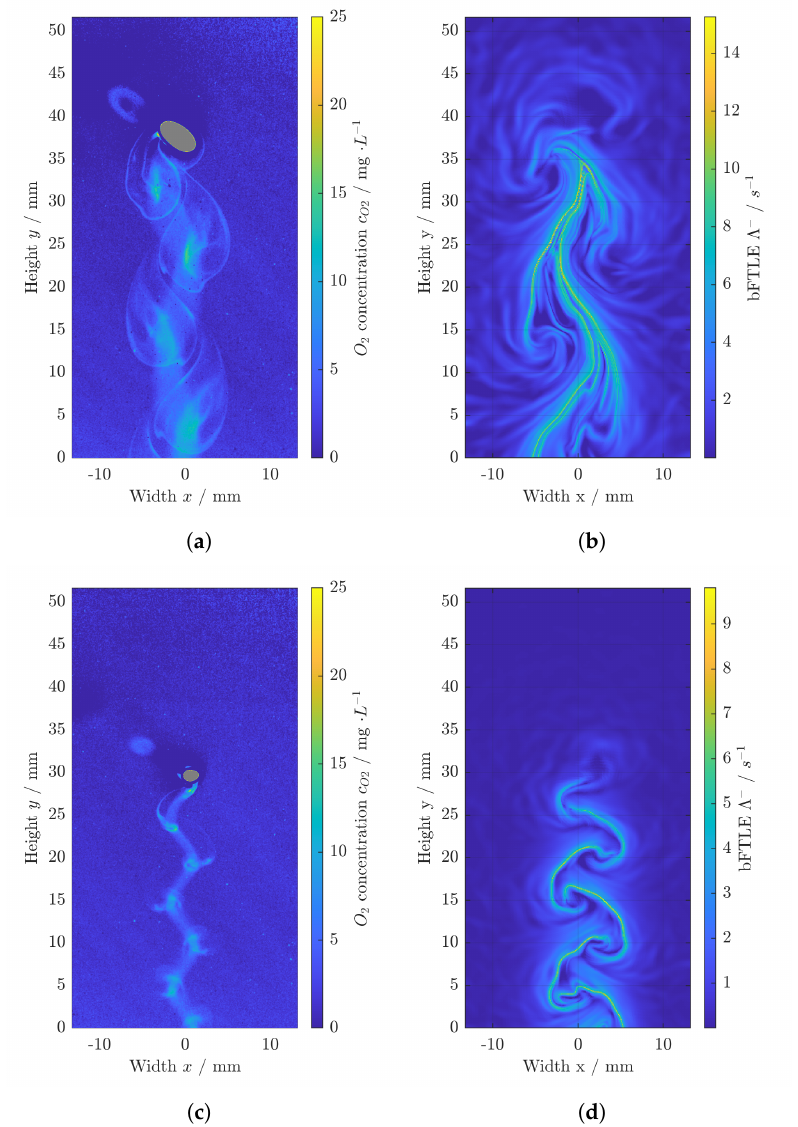
Figure 6. Comparison of concentration and bFTLE fields. ( a ) Concentration field wobbling bubble at t = 0.324 s, ( b ) bFTLE field wobbling bubble for the finite-time interval τ ∈ [0.324 s, 0 s], ( c ) Concen- tration field ellipsoidal bubble at t = 0.360 s and ( d ) bFTLE field ellipsoidal bubble for the finite-time interval τ ∈ [0.360 s, 0